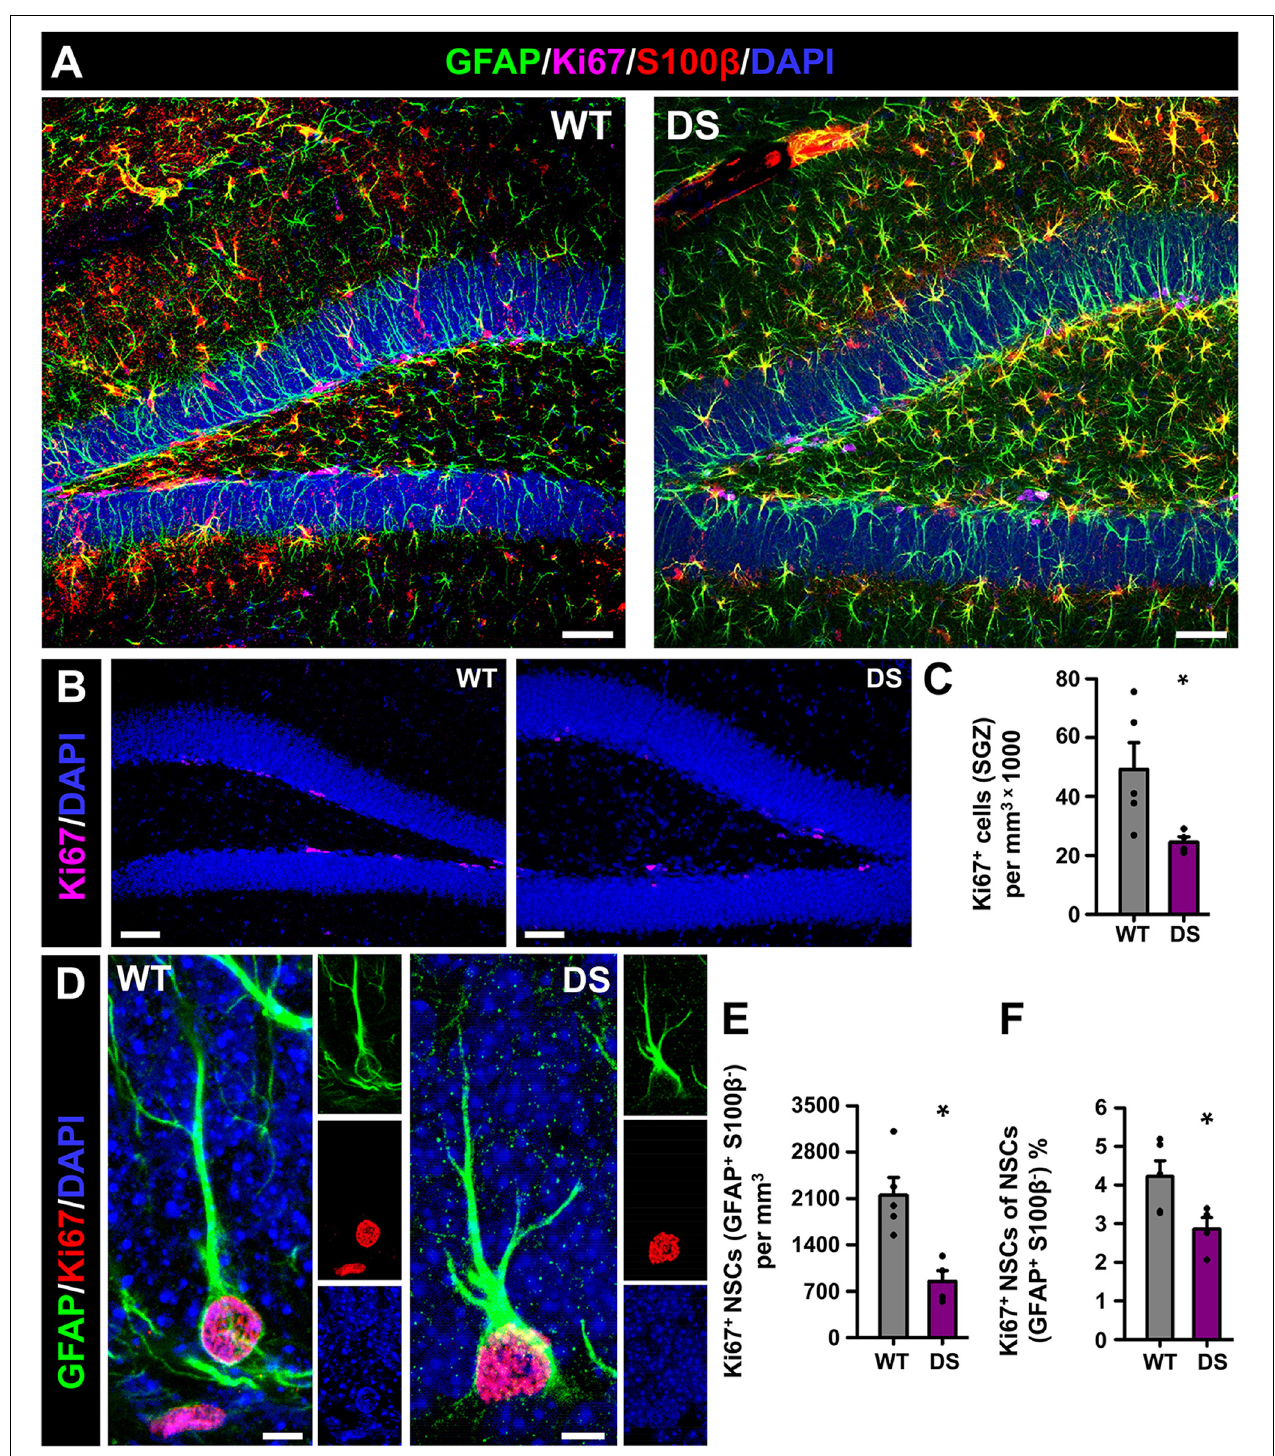
FIGURE 2 | Alterations NSC activation in DS mice. (A) Representative confocal-microscopy images of the DG of WT (left) and DS (right) mice after staining for GFAP (NSCs and astrocytes), S100 β (astrocytes), and the proliferation marker Ki67. DAPI was used to stain cell nuclei. Ki67 + -cells were restricted to the SGZ in WT and DS mice (B) . Fewer proliferating cells (Ki67 + ) were found in the DS mice (C) . (D) High-magnification confocal-microscopy images of dividing NSCs in WT (left) and DS (right, note the ramified morphology). The total number (E) as well as the proportion of dividing (Ki67 + ) NSCs was lower in the DS mice (F) . * p < 0.05 by Student’s t -test. n = 5 for each condition. Bars show mean ± SEM. Dots show individual data. Scale bar in (A) is 40 µ m, 50 µ m in (B) and 5 µ m in (D) .